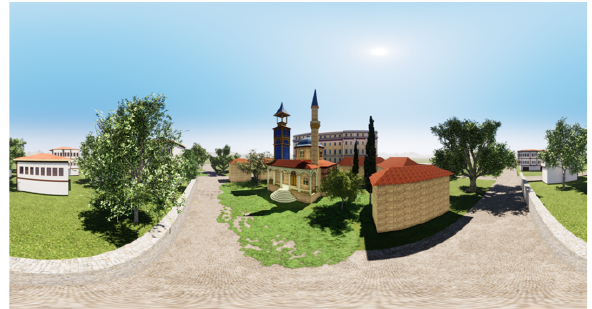
Figure 8. Panoramic image for VR mobile applications of Saatli